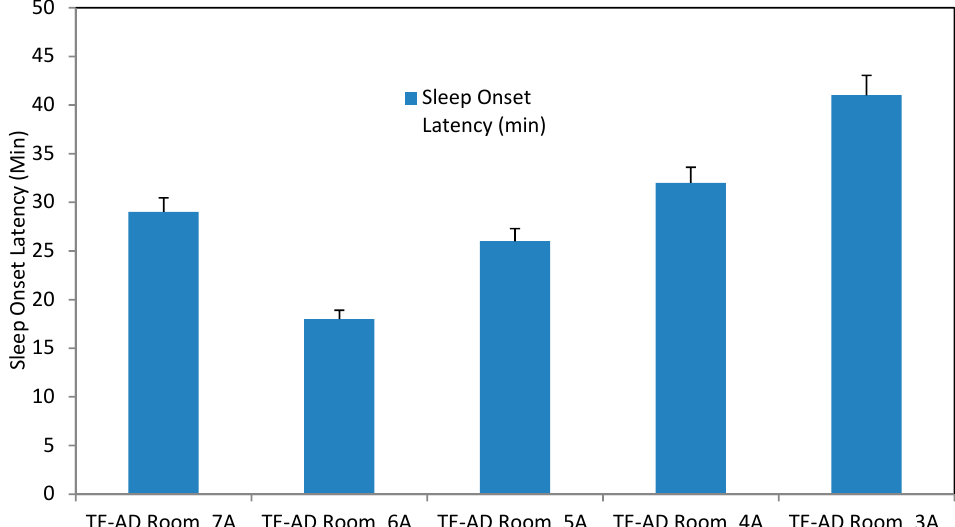
Figure 13. Variation in sleep onset latency with varying operating powers.